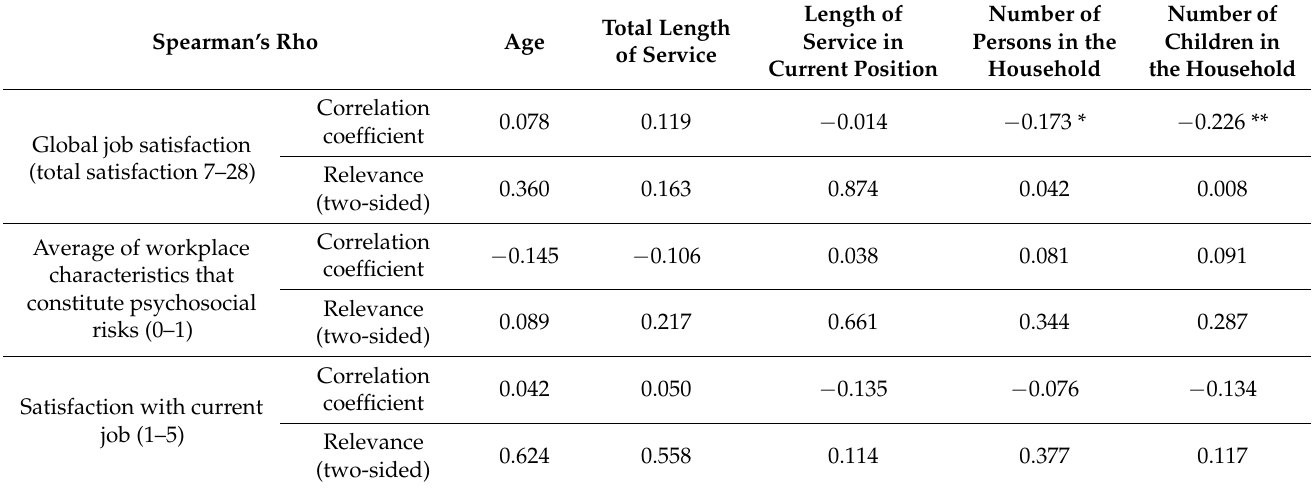
Table 4. Correlation of sociodemographic data with Psychosocial Risk Scale scores ( N =